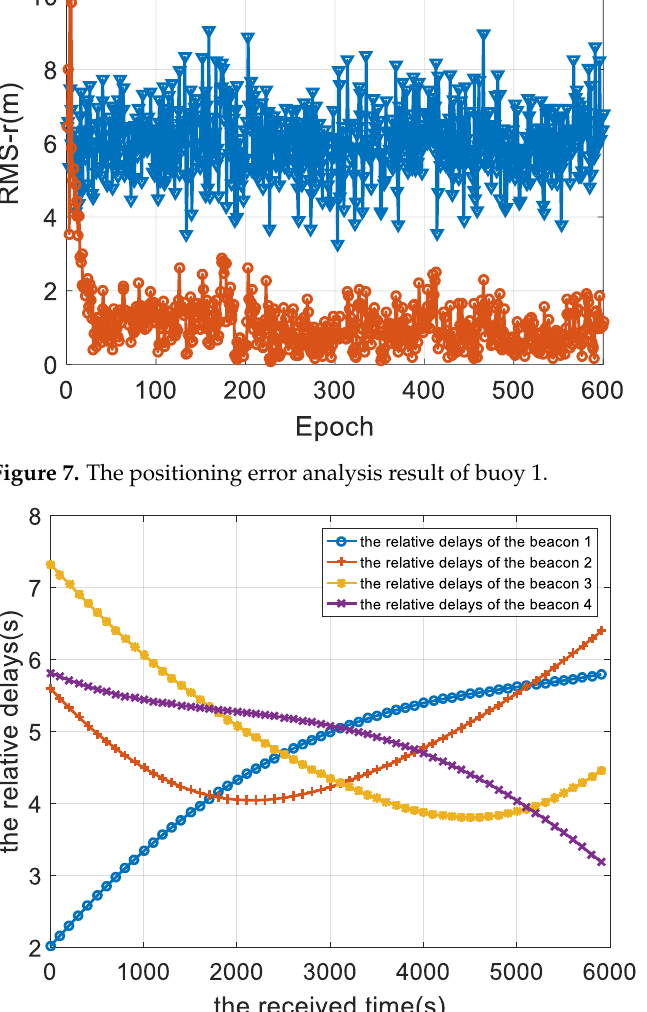
Figure 8. Relative time delay result of the location signal.